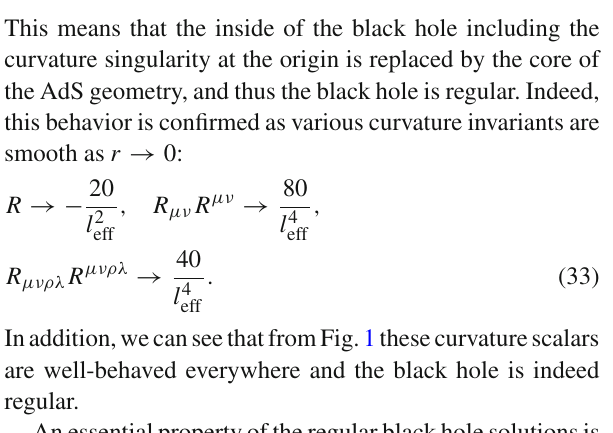
Fig. 1 Plots of the curvature scalars R , R μν R μν , and R μνρλ R μνρλ in terms of r , under the different values of k and α , at q 2 blue, red, green, purple and pink curves correspond to k = 0 . 1, 0.12, 0.14, 0.16, 0.18,